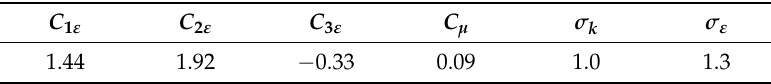
Table 2. Experimental constants for the k − ε model